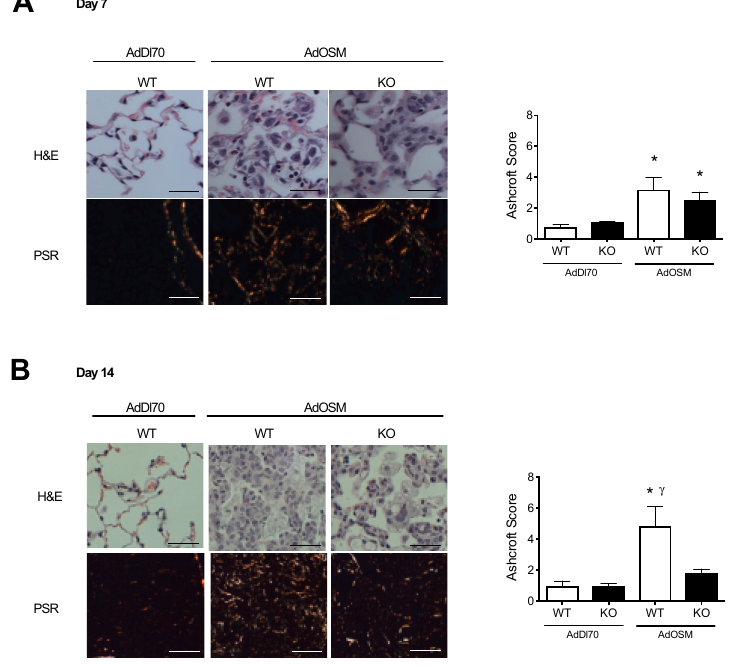
Figure 1. Prolonged induction of interstitial collagen in the lungs of AdOSM-infected BALB/c mice is reduced in IL-13-deficient mice. Wildtype (WT) and IL-13-/- (KO) BALB/c mice were treated with an endotracheal administration of AdDl70 or AdOSM (5 × 10 7 pfu), culled at day 7 ( A ) or day 14 ( B ), and tissues were prepared for histology. Images of H&E and picrosirius red (PSR) stained tissue sections are shown from mice treated with AdDl70 or AdOSM. Quantification of picrosirius red staining was completed by Ashcroft scores to assess the degree of staining in the lung parenchyma. Data i shown as the mean +/ − SEM ( n = 5 per group). White bars are wildtype and black bars are IL-13-/- data. Scale bars for photomicrographs represent a length of 100um. * indicates significant difference of p < 0.05, as compared to AdDl70-treated mice. γ indicates significant difference of p < 0.05 as compared to AdOSM-treated IL-13-/-